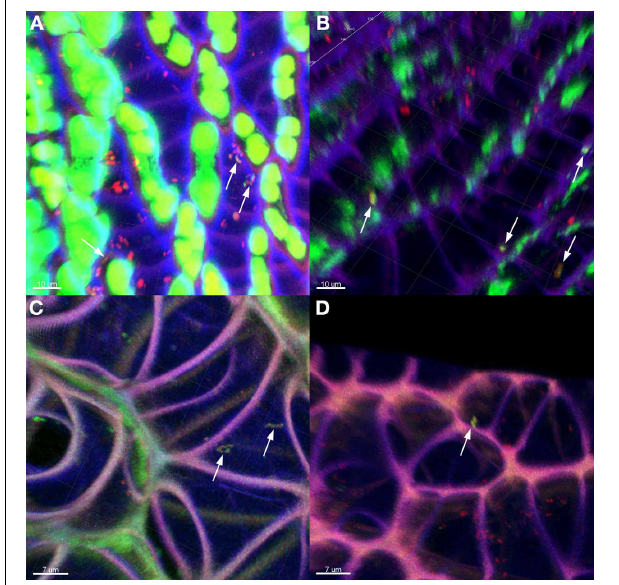
FIGURE 4 | Detection of Burkholderia in Sphagnum plants by FISH-CLSM visualization. Branch leaves of S. fallax (A,B) and S. magellanicum (C,D) from Austrian (A,C) and Russian (B,D) bogs hybridized with Burkholderia -specific and universal bacterial probes. Yellow: Burkholderia spp. indicated by arrows; red: other bacteria; green: algae, Sphagnum chlorocytes; violet: moss cell walls. Scale bar = 10 µ m (A,B) ; 7 µ m (C,D)